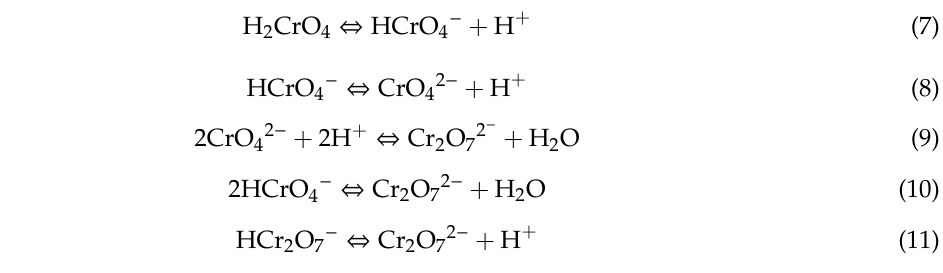
Figure 3. Infrared spectrum of Fe 3 O 4.